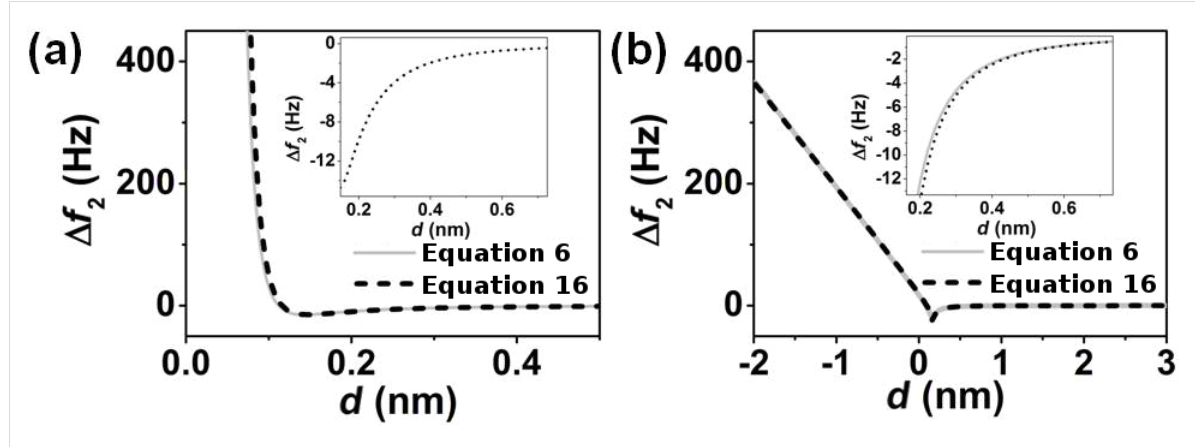
Figure 3: Comparison between the general expression (Equation 6) and the half-derivative (Equation 16) relationship to the frequency shift of the second mode in bimodal FM-AFM for two different forces. (a) Lennard-Jones force characterized by ε = 0.5 · 10 − 20 J and σ = 0.1 nm, and A 1 = 4 nm; (b) DMT force characterized by H = 0.2 · 10 − 20 J, E eff = 300 MPa, and A 1 = 10 nm.